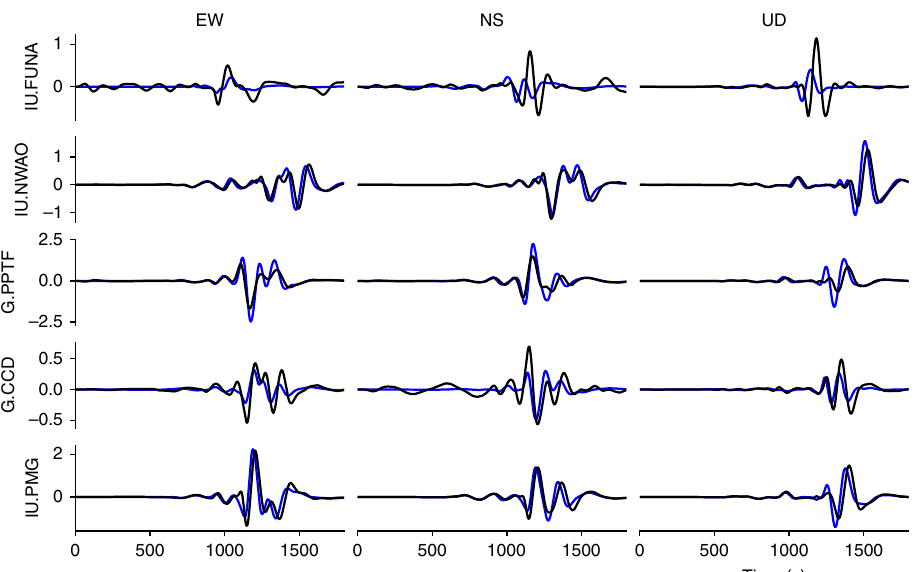
Fig. 10 Comparison of modeled (blue) and observed (black) teleseismic waveforms. A 100 – 450 s band-pass fi lter is applied to all traces. Synthetics are generated using Instaseis 47 and the PREM model including anisotropic effects and a maximum period of 2